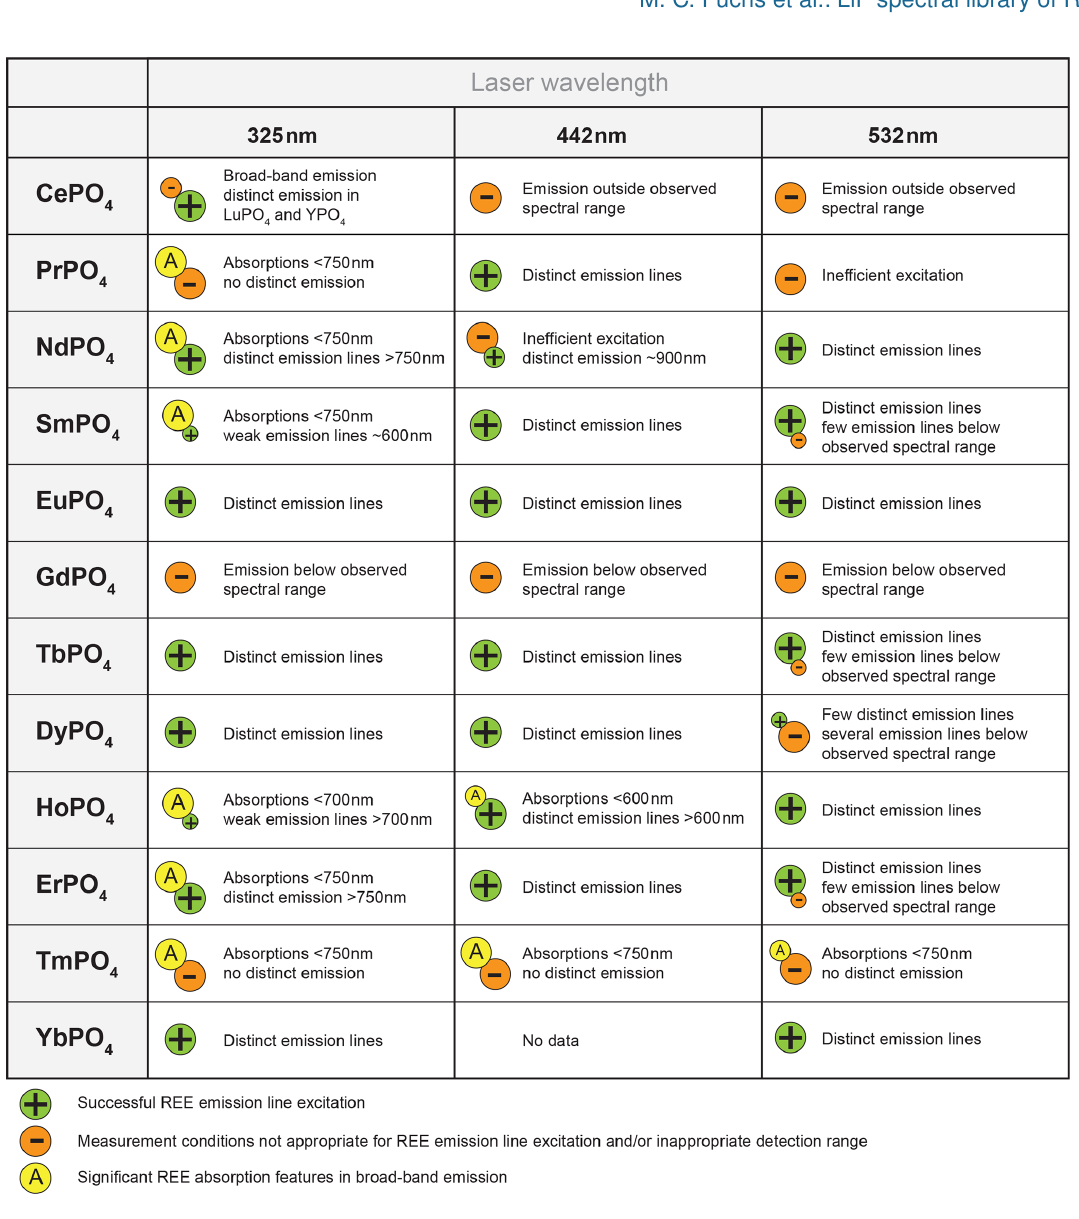
Figure 10. Summary of the evaluation of suitable laser wavelengths for an efficient excitation of individual REEs ( + : good conditions; − : bad conditions; A: absorption features